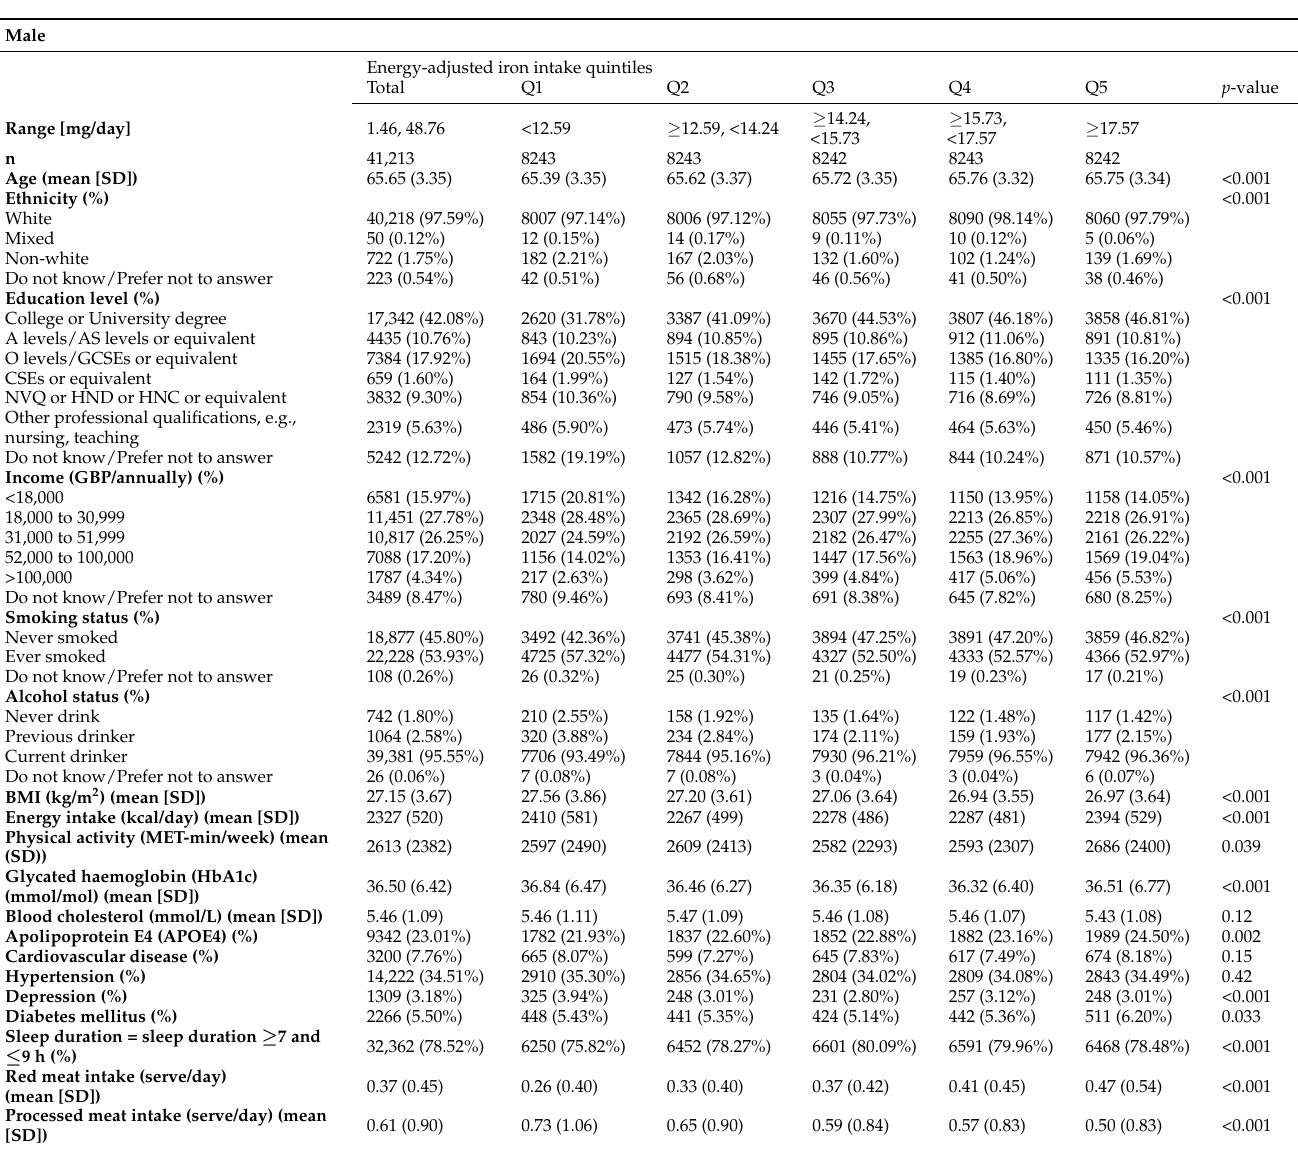
Table 1. Baseline characteristics according to iron intake. Abbreviations: Q, quintile; n, sample size; SD, standard deviation. The baseline characteristic is presented for different genders